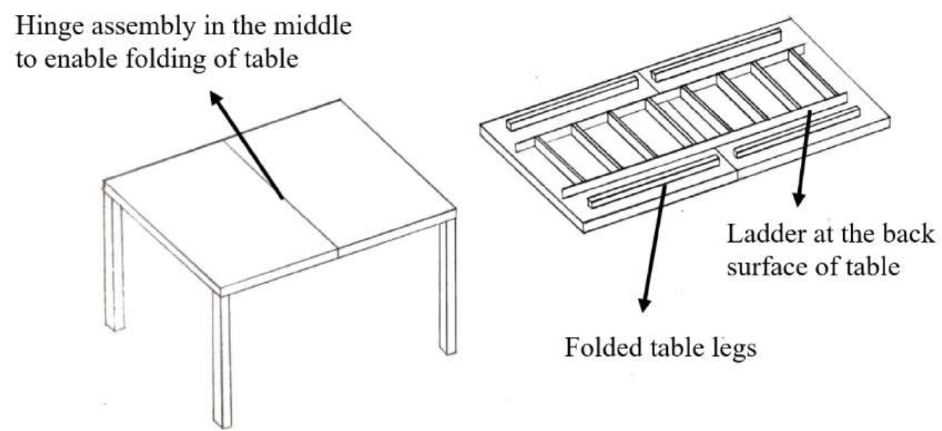
Figure 3. Hand sketch of concept